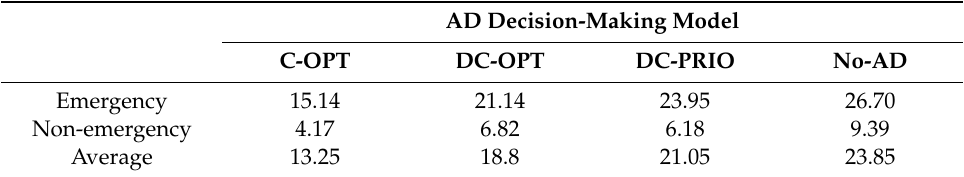
Table 3. Average tardiness of patients for four models (unit: min).